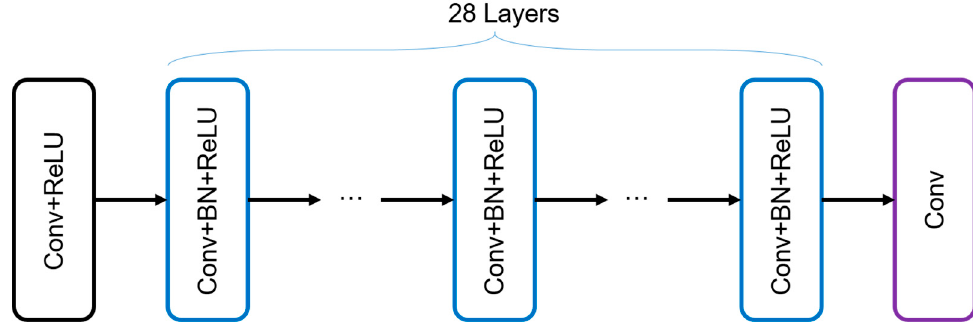
Figure 3. The architecture of the CNN.